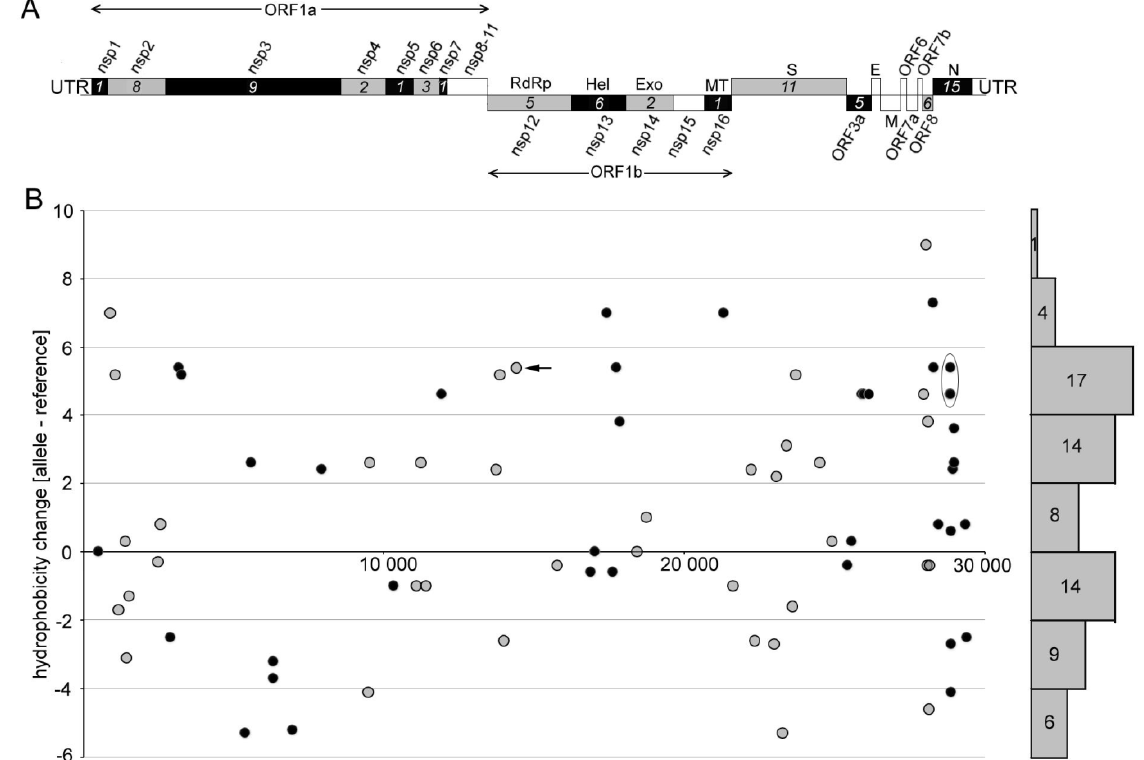
Figure 3. Distribution of non-synonymous substitutions along the SARS-CoV-2 genome and the character of induced amino acid changes. ( A ) A scheme of the SARS-CoV-2 genome organization. Numerals in italics indicate the number of substitutions identified within each gene. Genes with no detected substitution are in empty boxes. Nsp1-16 indicate genes for nonstructural proteins: RdRp: RNA-dependent RNA polymerase; Hel: helicase; Exo: 3 ′ -to-5 ′ exonuclease; Met: 2'-O-ribose methyltransferase. Structural proteins are represented by surface glycoprotein (S), membrane glycoprotein (M), nucleocapsid phosphoprotein (N), and envelope protein (E). ( B ) Characters of amino acid hydrophobicity changes were computed using the hydrophobicity scale of Kyte and Doolittle [33] (Table S6). For better resolution, values (circles) are shown in black or gray colors, which assign them to the same colored (black and gray) genes in panel A. Number of substitutions in individual hydrophobicity intervals is given on the right margin. Arrow—the widespread Pro323Leu substitution within the NSP12 protein. Oval—cluster of C>U substitutions underlying prominent amino acid changes in the linker region of the N-protein.